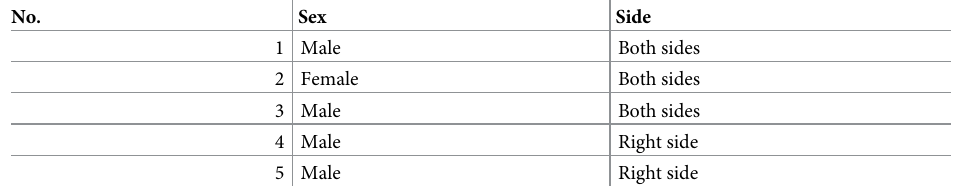
Table 1. Koala specimens used in this study. No.